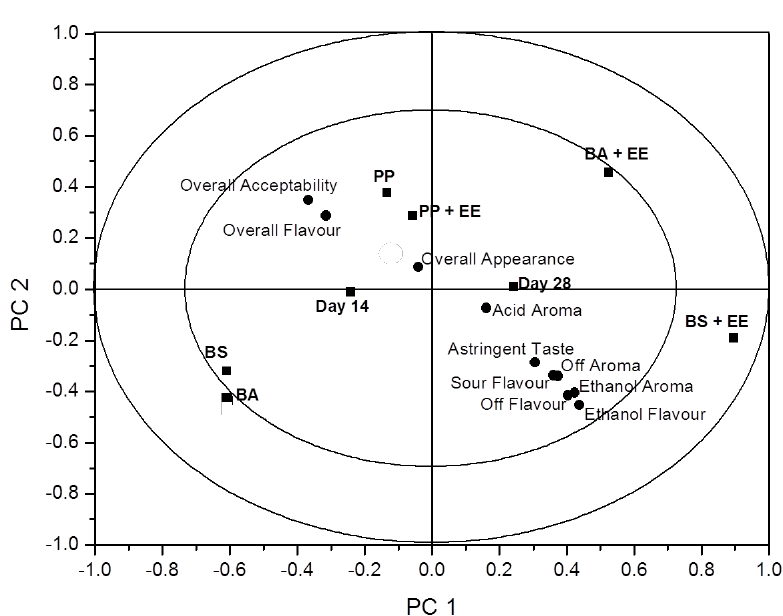
Figure 1. An overview of the variation found in the mean data from the ANOVA-partial least squares regression (APLSR) correlation loadings plot for each of the eight treatment groups assessed by a trained sensory group. Shown are the loadings of the X - and Y -variables for the first two principle components (PC’s) for averaged data validated over replicates. ■ = sample and days of analysis; ● = sensory